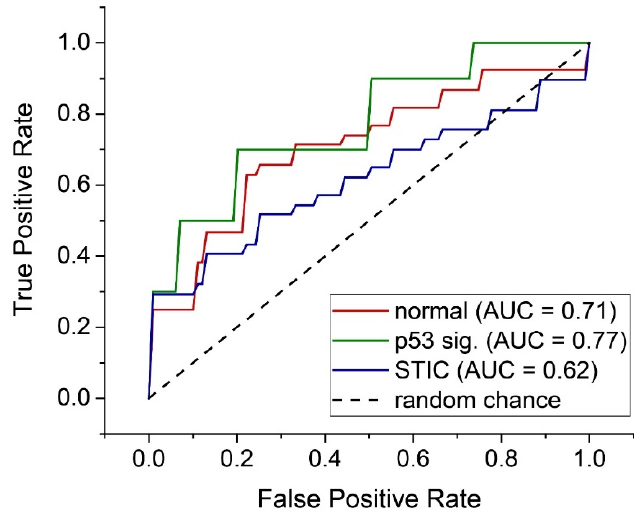
Figure 6. Individual ROC curves for each OvR classifier for the three tissue